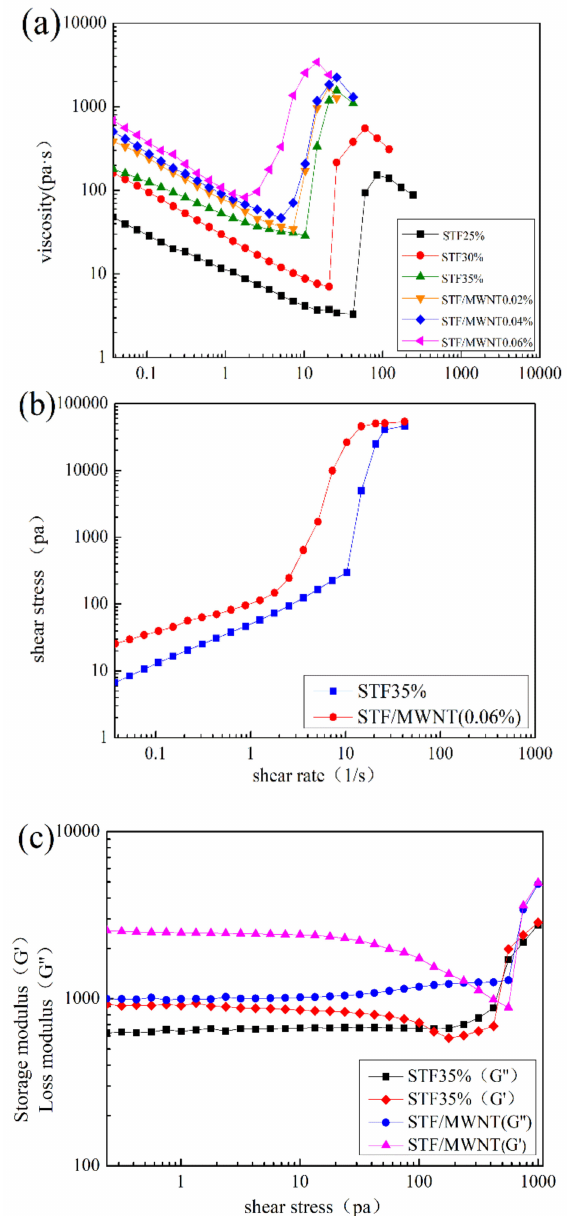
Figure 4. ( a ) Viscosity and ( b ) shear stress versus shear rate; ( c ) Storage (G (cid:48) ) and loss (G”) modulus versus shear stress for 35% STF and 0.06% M-MWNT/STF. Table 3. Rheological properties and fitting functions of STF and M-MWNT/STF.